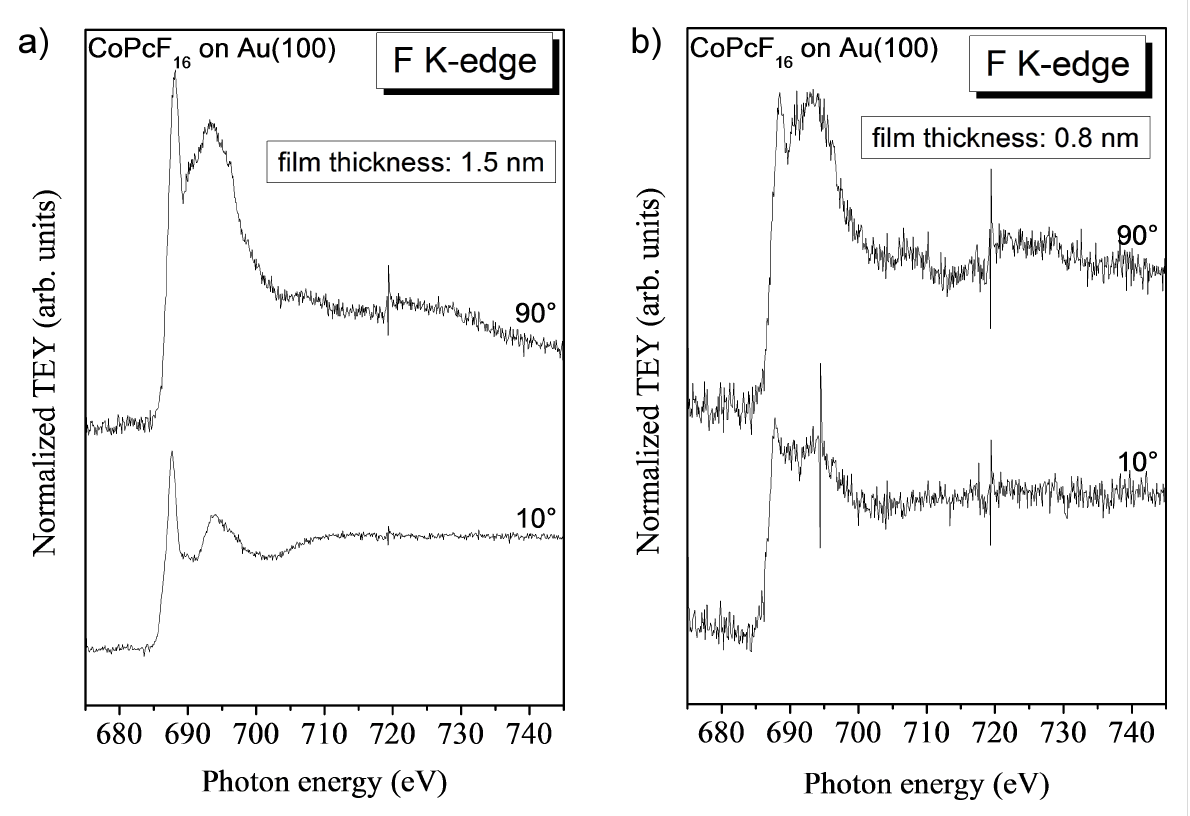
Figure 5: Angle dependent F K-edge XAS spectra for (a) 1.5 nm CoPcF 16 on Au(100) and (b) 0.8 nm CoPcF 16 on Au(100). The different peak shape in both cases indicates a different electron distribution at the interface.